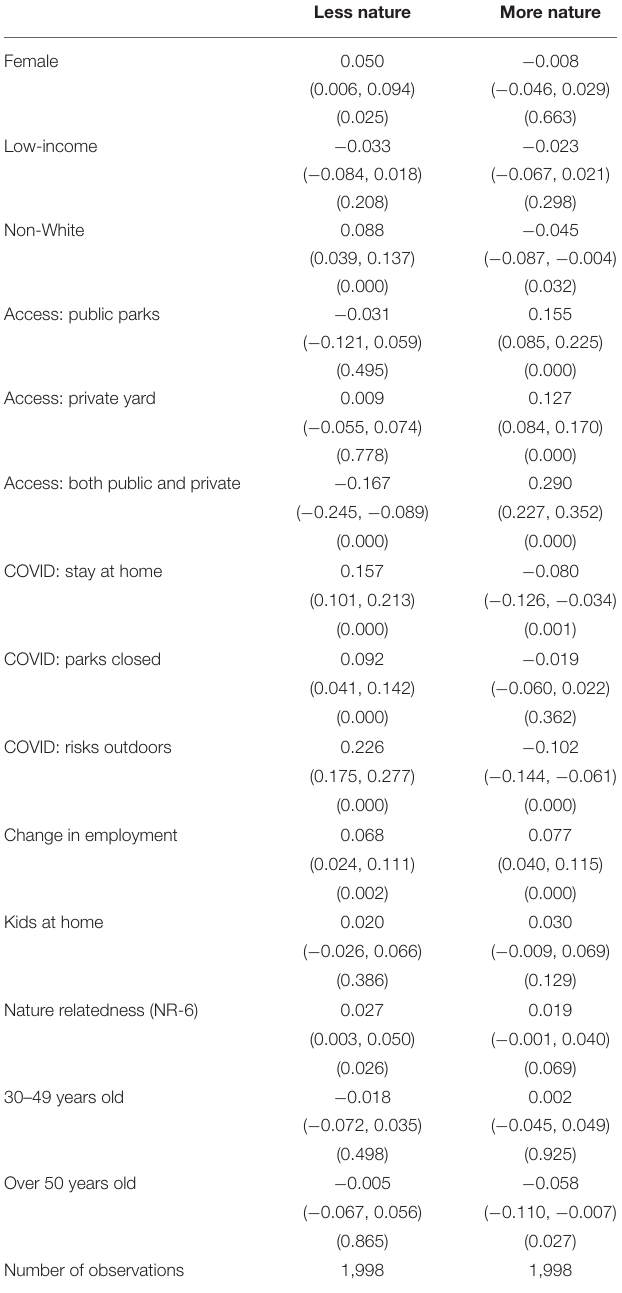
TABLE 2 | Average marginal effects of demographic, pandemic, and household characteristics on reported change in time spent in nature since the